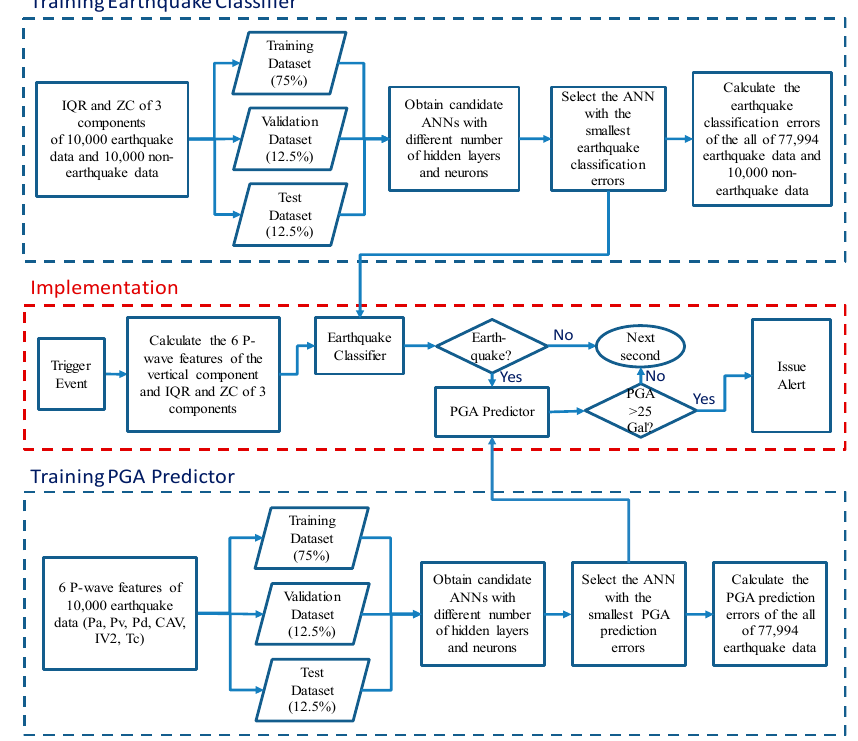
Figure 1. The flow chart of training the earthquake classifier, training the PGA predictor, and Figure 1. Theflowchartoftrainingtheearthquakeclassifier, trainingthePGApredictor, andimplementation implementation of these two models. of these two